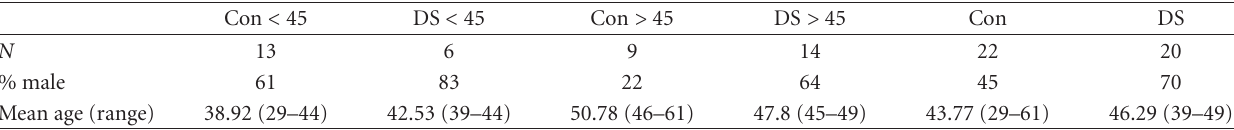
Table 1: Demographics of control and DS cohorts.